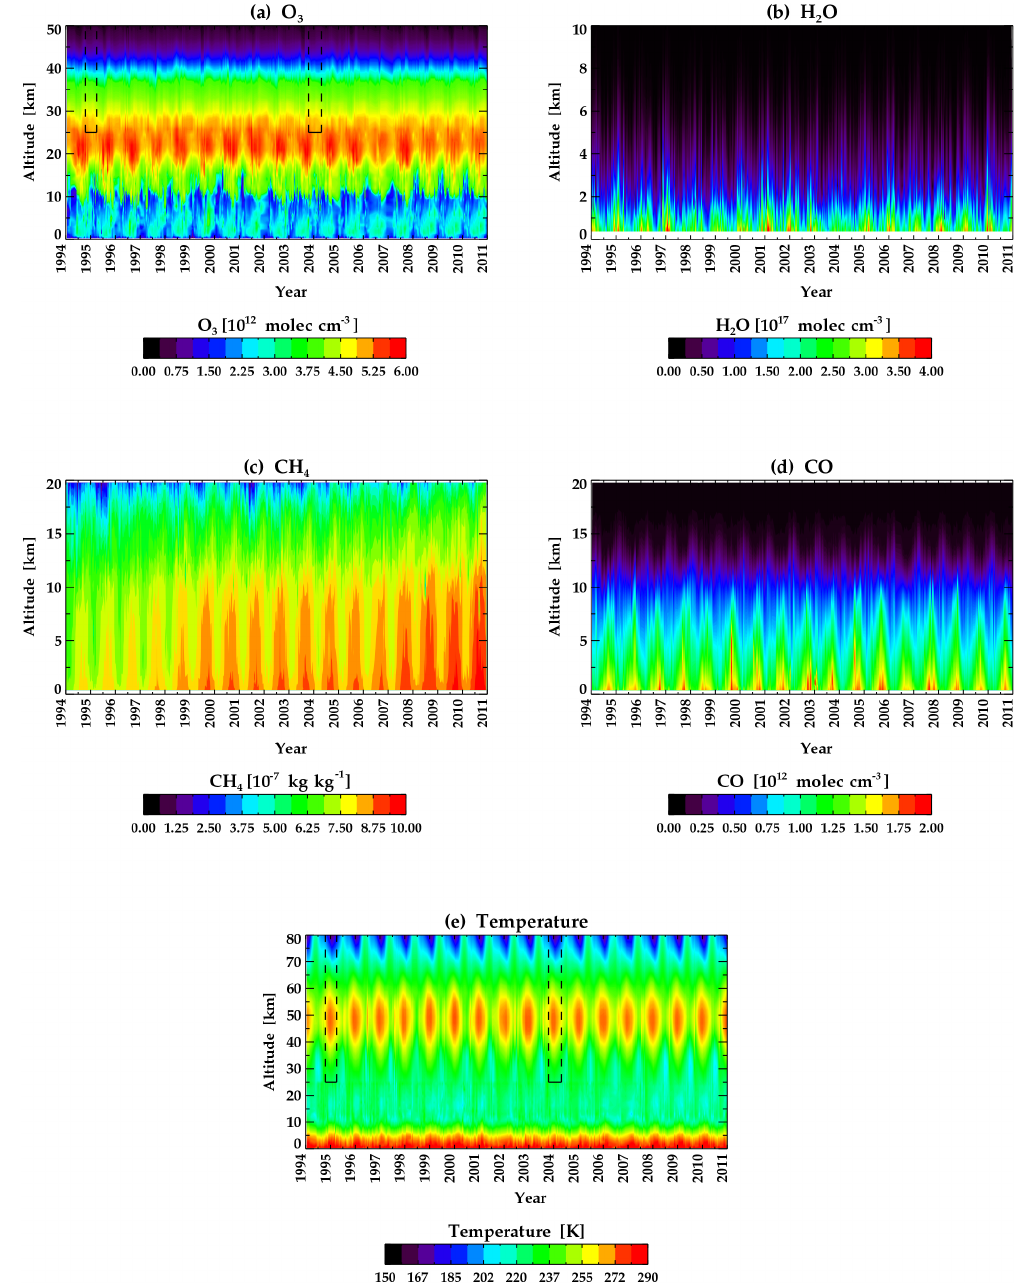
Figure 1. (a) Time series of O 3 profiles constructed by ozone sonde measurements spliced with MOPI1 measurements. (b) Time series of H 2 O profiles constructed by radiosonde measurements spliced with NIWA–UKCA H 2 O (time series of ERAI – NIWA–UKCA H 2 O is not displayed here). (c) Time series of CH 4 profiles constructed by rescaling the NIWA–UKCA CH 4 to surface CH 4 measurements from Cape Grim (Tasmania). (d) Time series of CO profiles constructed by rescaling the NIWA–UKCA CO to CO measurements from the FTIR spectrometer. (e) Time series of temperature profiles constructed by radiosonde measurements (up to 25km) merged with NCEP/NCAR reanalyses up to the stratopause (50km) and a mesospheric climatology based on local lidar measurements. Above 25km these data are as used in the retrieval of O 3 from MOPI1 measurements. The areas within black boxes were filled using a Fourier series gap filling